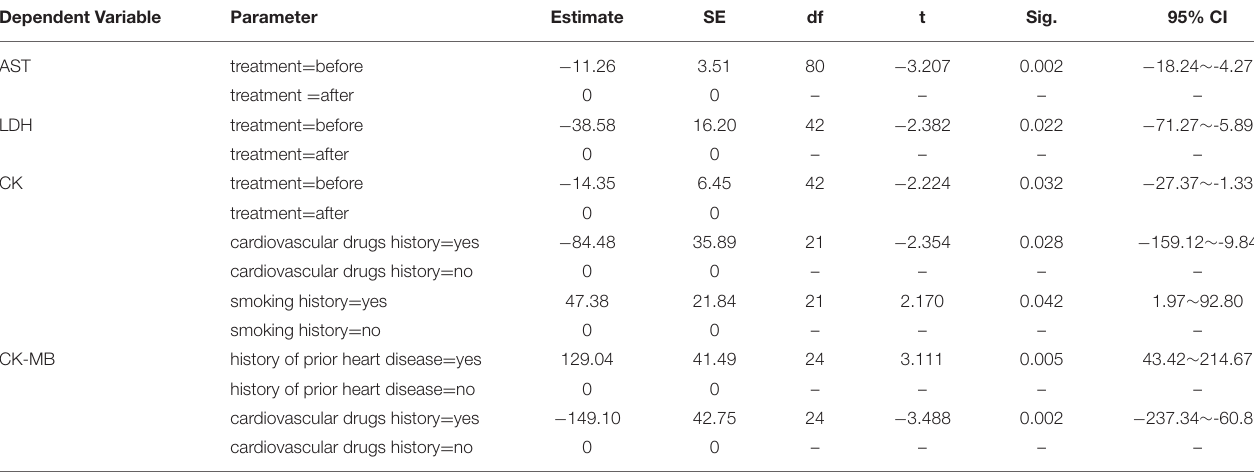
TABLE 7 | Estimates of fixed effect of treatment, cardiovascular drugs history, history of prior heart disease, and smoking history on serum AST, LDH, CK, and CK-MB activities. Dependent Variable